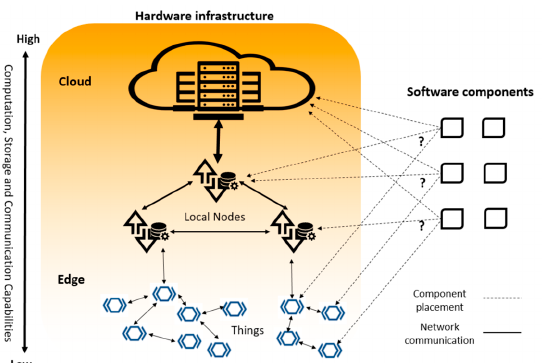
Figure 1. The software component deployment problem in Internet of Things (IoT) system design. Each component may be deployed either in the cloud, in local nodes (e.g., local servers or gateways), or on the things.